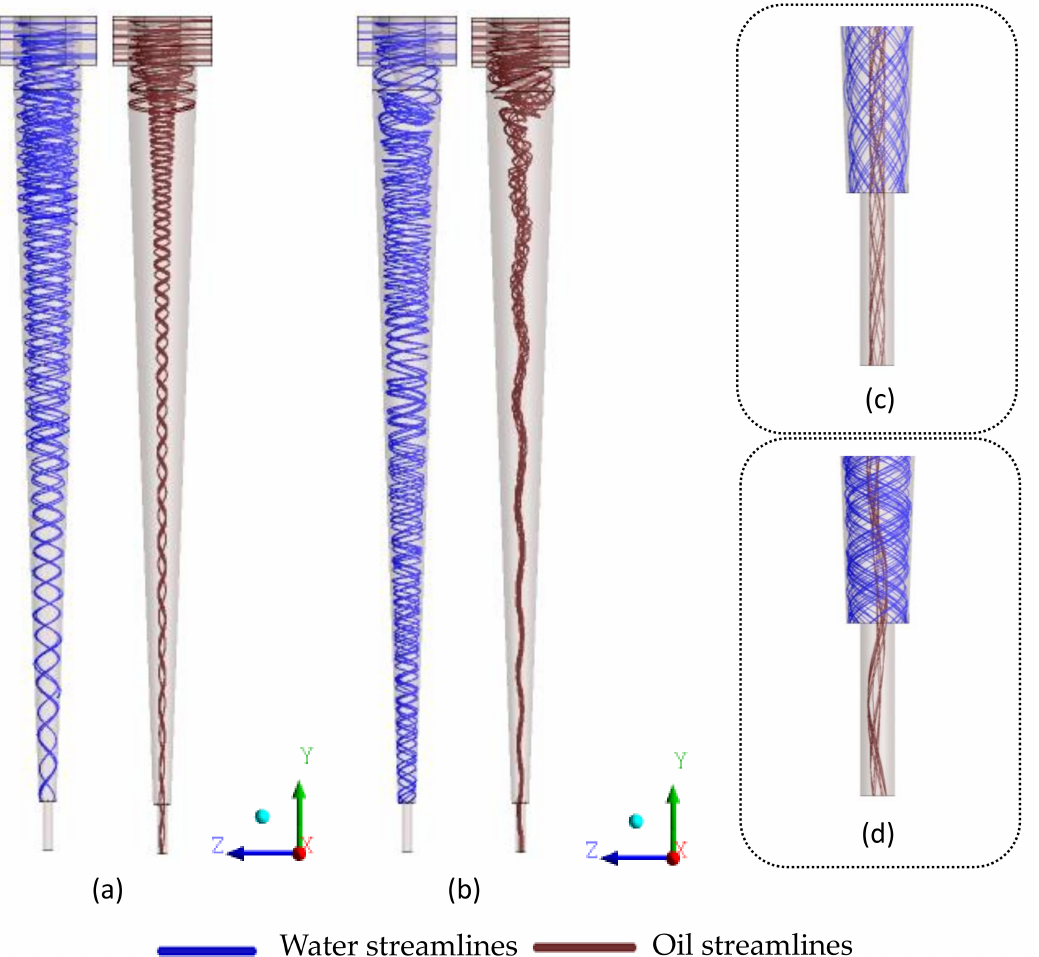
Figure 4. Water and oil streamlines inside the separation equipment. ( a ) Conventional cyclonic separator, ( b ) filtering cyclonic separator, ( c ) detail of the conventional cyclonic separator outlet, and ( d ) detail of the filtering cyclonic separator